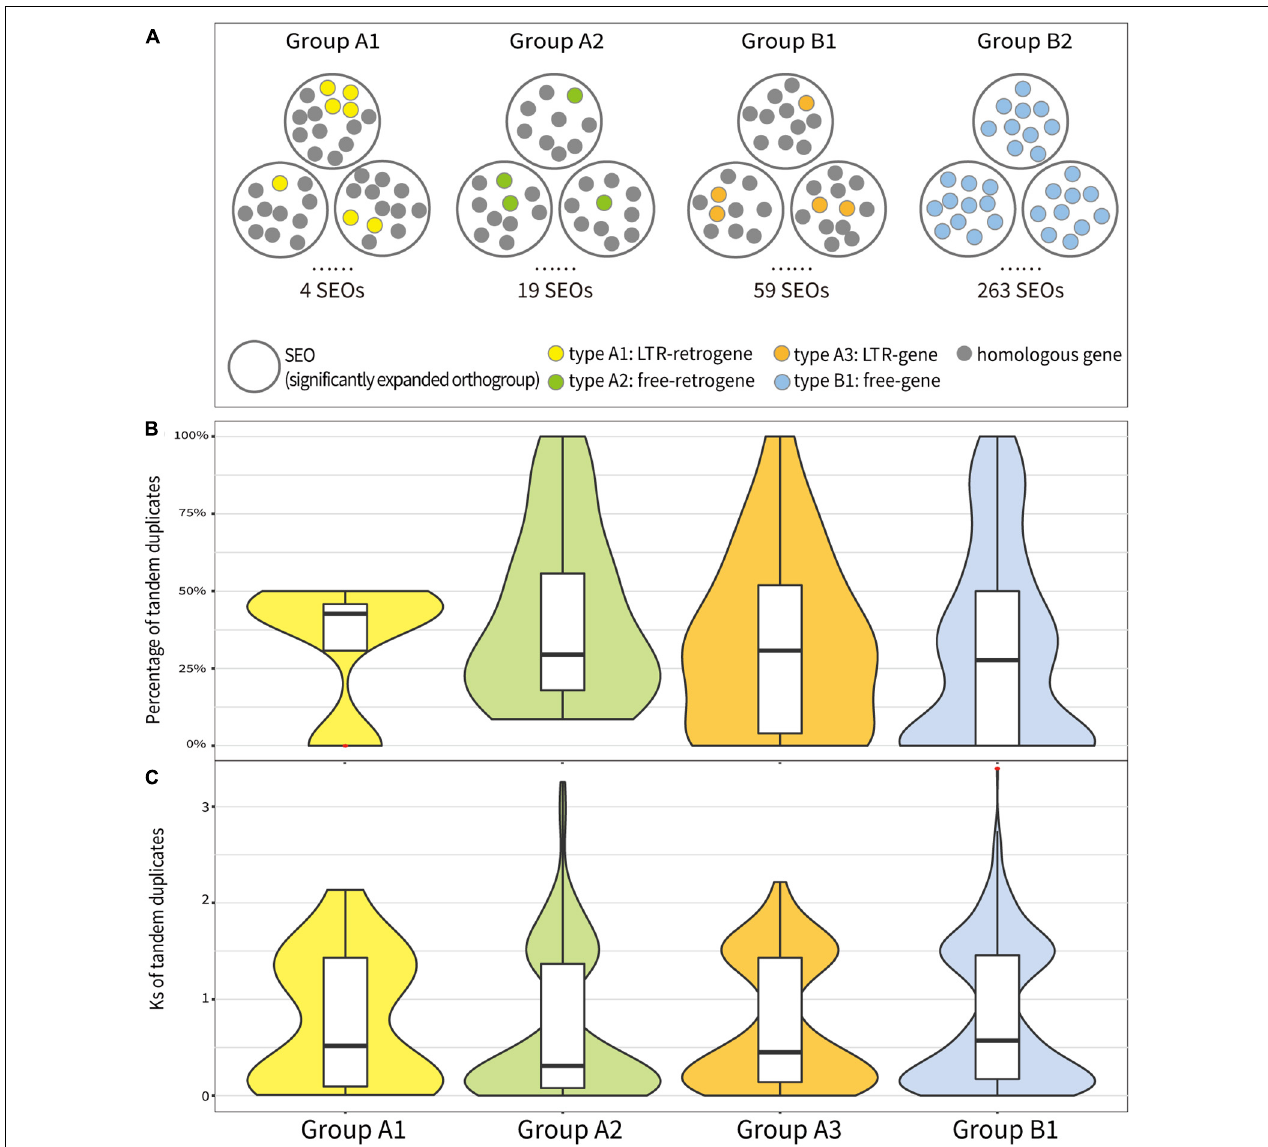
FIGURE 4 | Analysis of tandem duplicated genes in significantly expanded orthogroups (SEOs) in Groups A1, A2, A3, and B1. (A) Conceptual diagram of analysis method for the tandem duplicated genes in SEOs in four groups. (B) The percentage of tandem duplicated genes of each SEO in four groups. (C) The Ks values of tandem duplicated genes in each SEO in four groups. Red asterisks represent